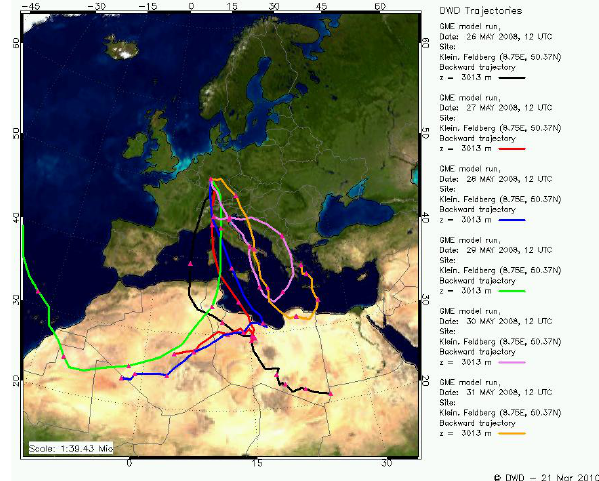
Fig. 2. Backward trajectories arriving at the Taunus Observatory during 26–31 May 2008, calculated by the German Meteorological Service